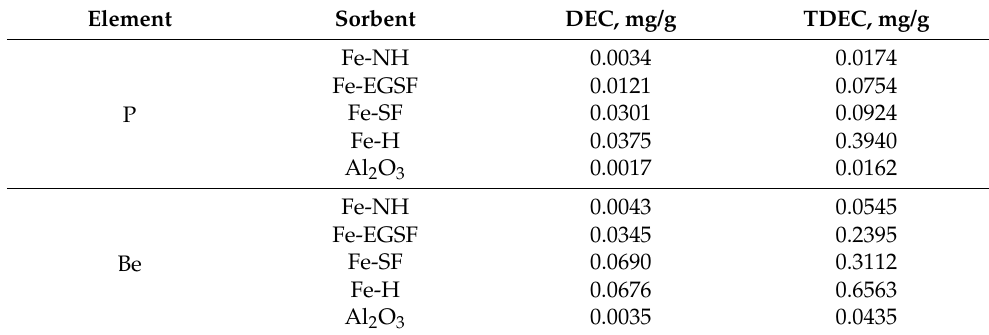
Table 4. Values of DEC and TDEC of various sorbents for phosphorus or beryllium. Element Sorbent